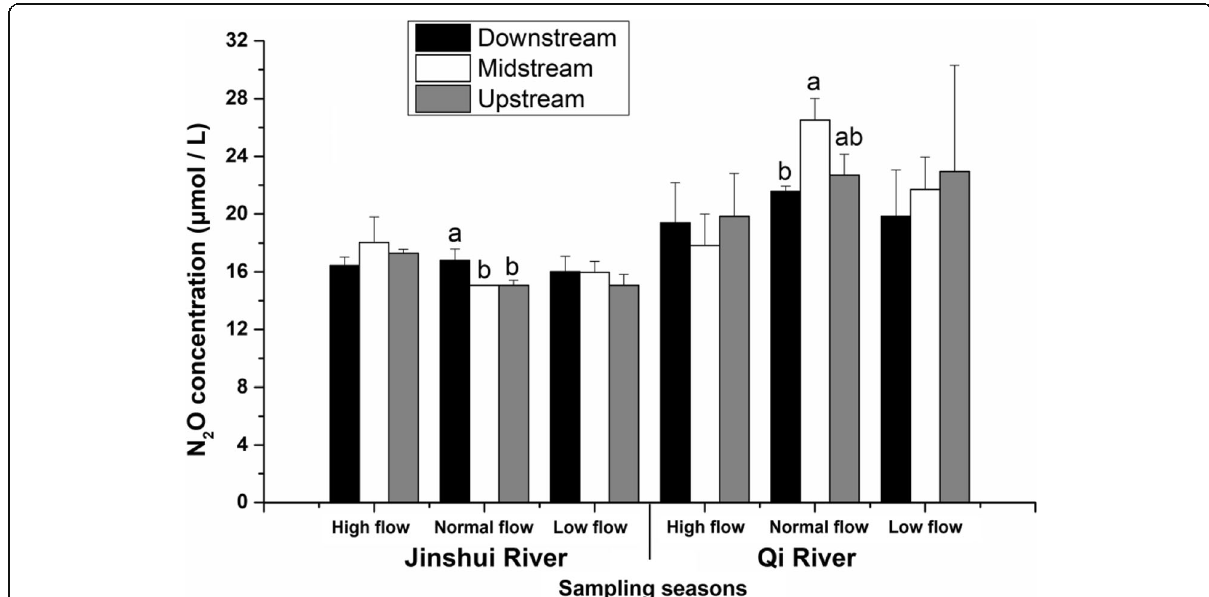
Fig. 2 N 2 O concentration in the Jinshui River and Qi River. Vertical bar denote SE of triplicate samples. Different letters indicate significant differences among sampling areas by linear mixed modeling ( P < 0.05)